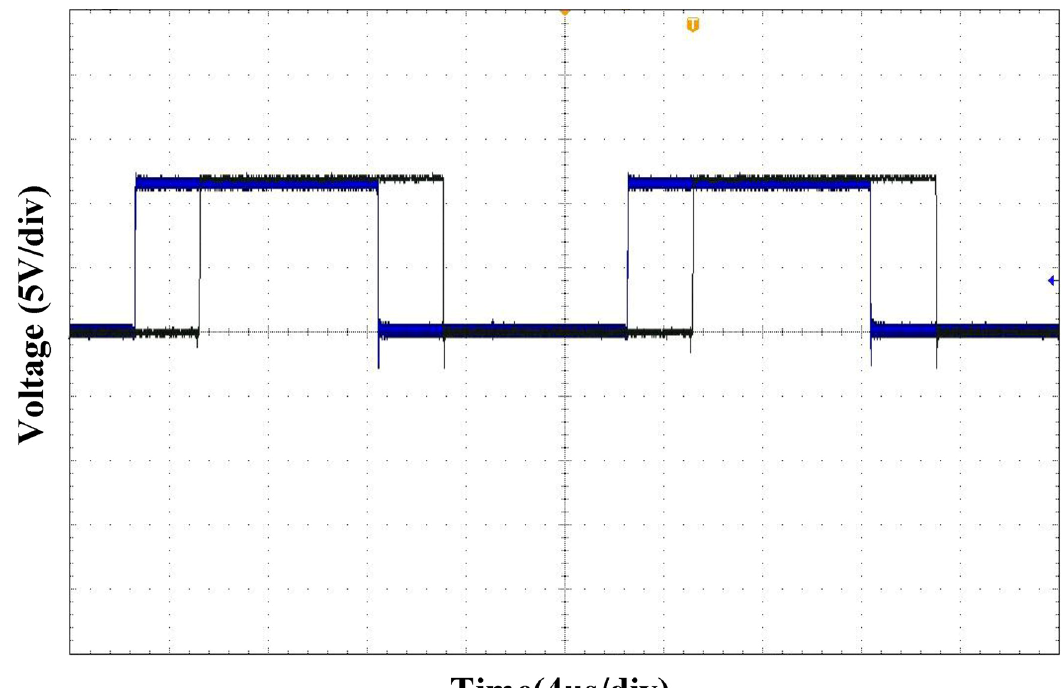
Fig 22. MOSFET driving waveforms of the leading-leg and lagging-leg.